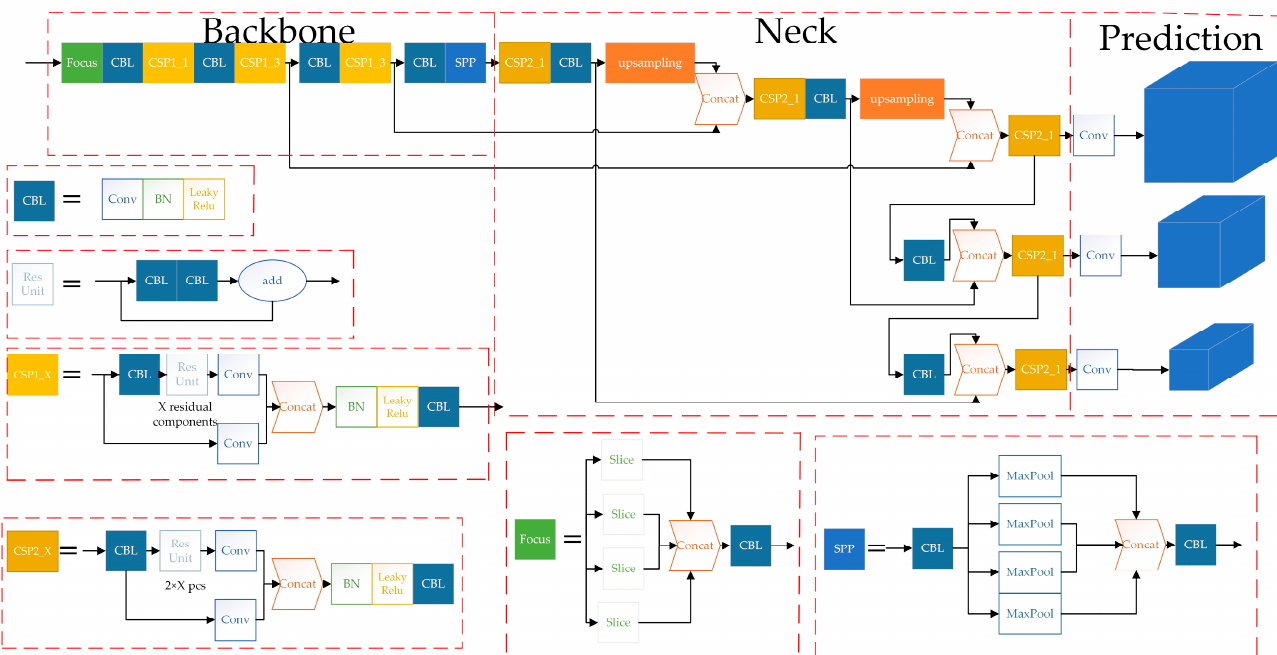
Figure 8. The overall architecture of the original YOLOv5s